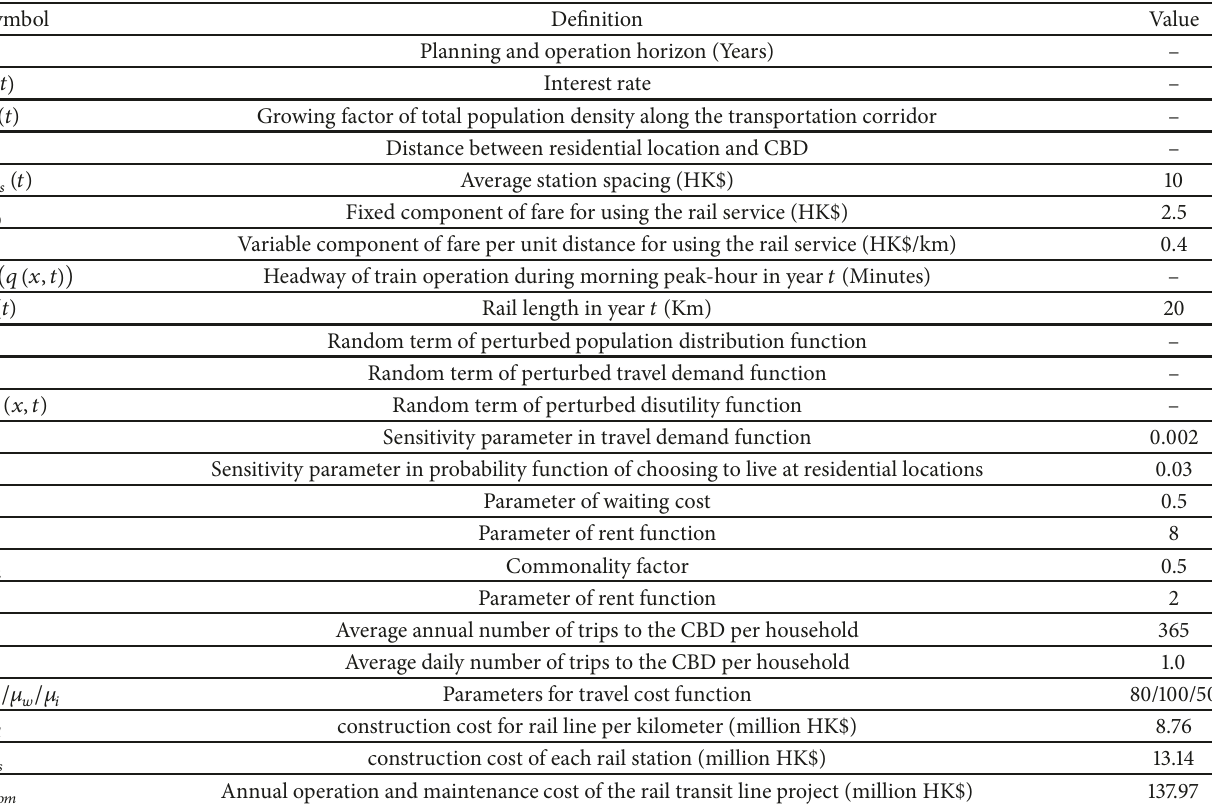
Table 4: Notations.